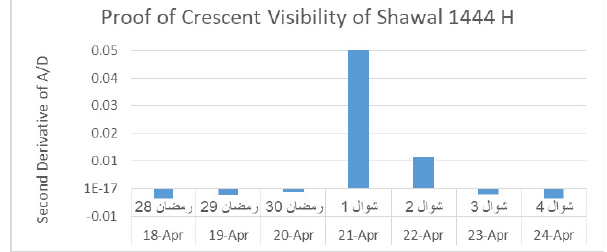
Figure 13. The Present Model Crescent Visibility of Shawal 1444